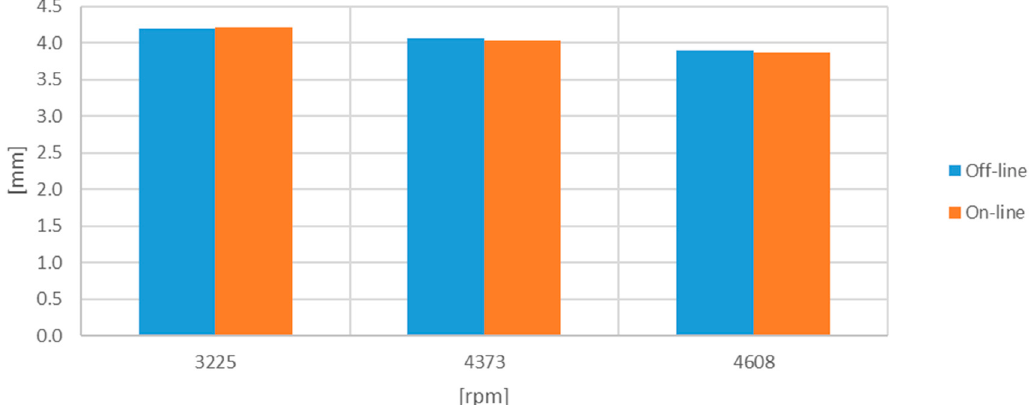
Figure 13. Minimum TC [mm] obtained with the ten-turn-filtered set of signals.